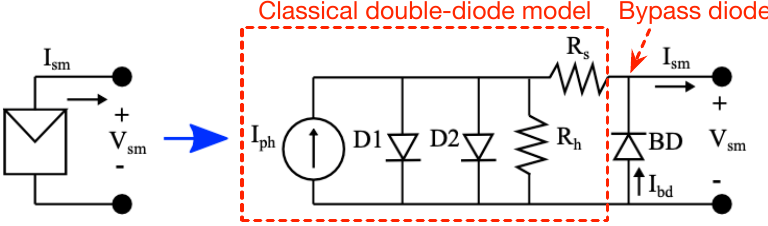
Figure 2. Equivalent circuit of the double-diode model used to represent each